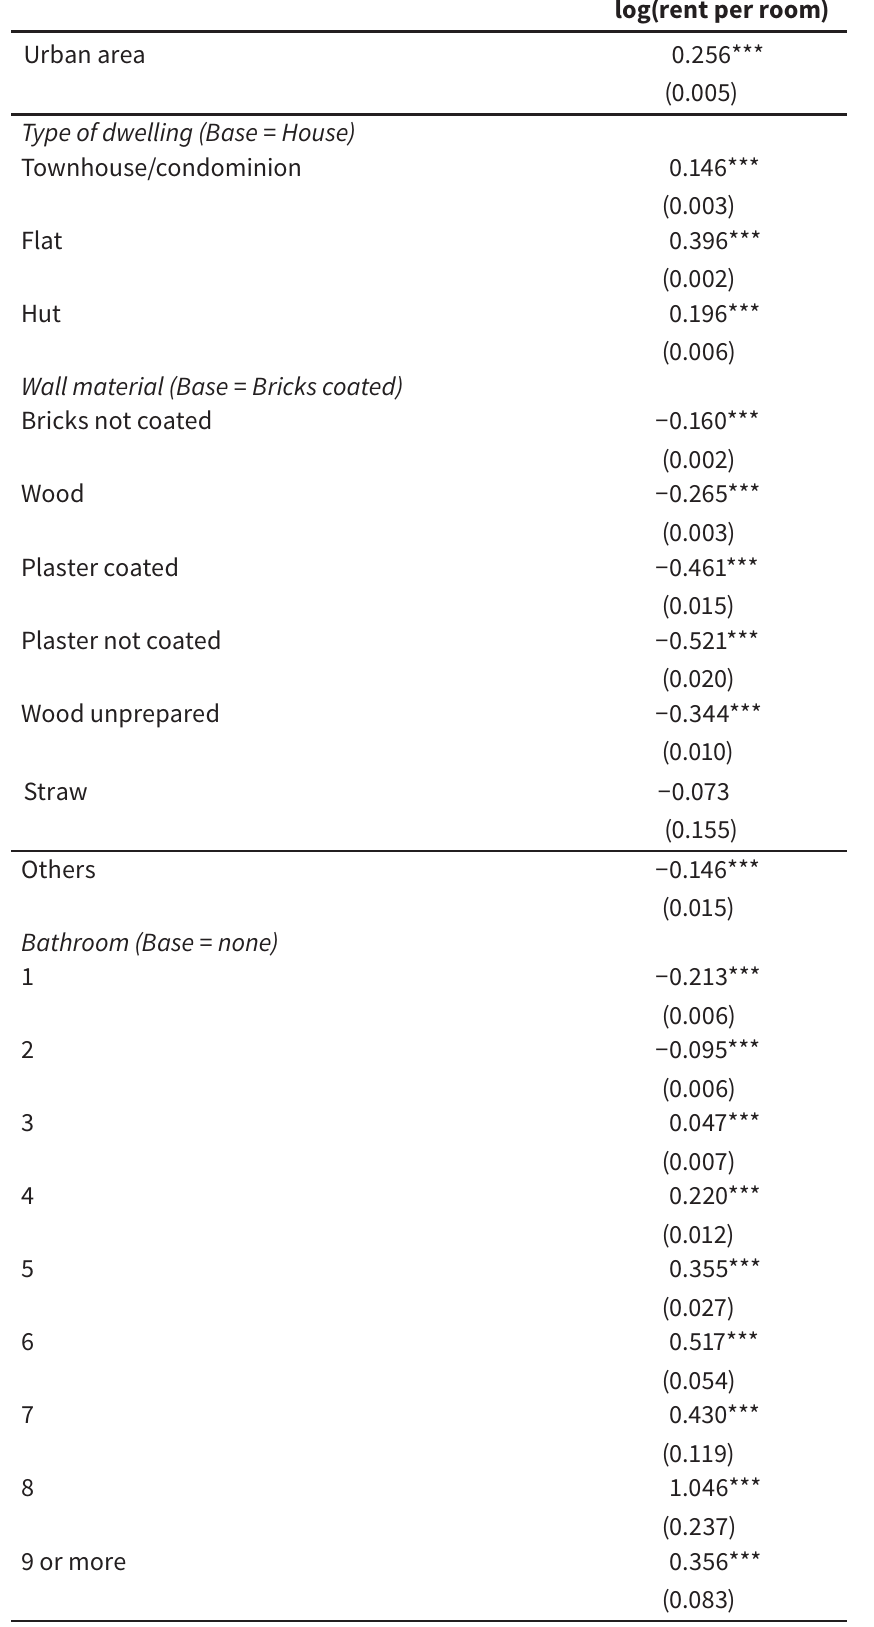
Regression of housing prices on housing characteristics, OLS